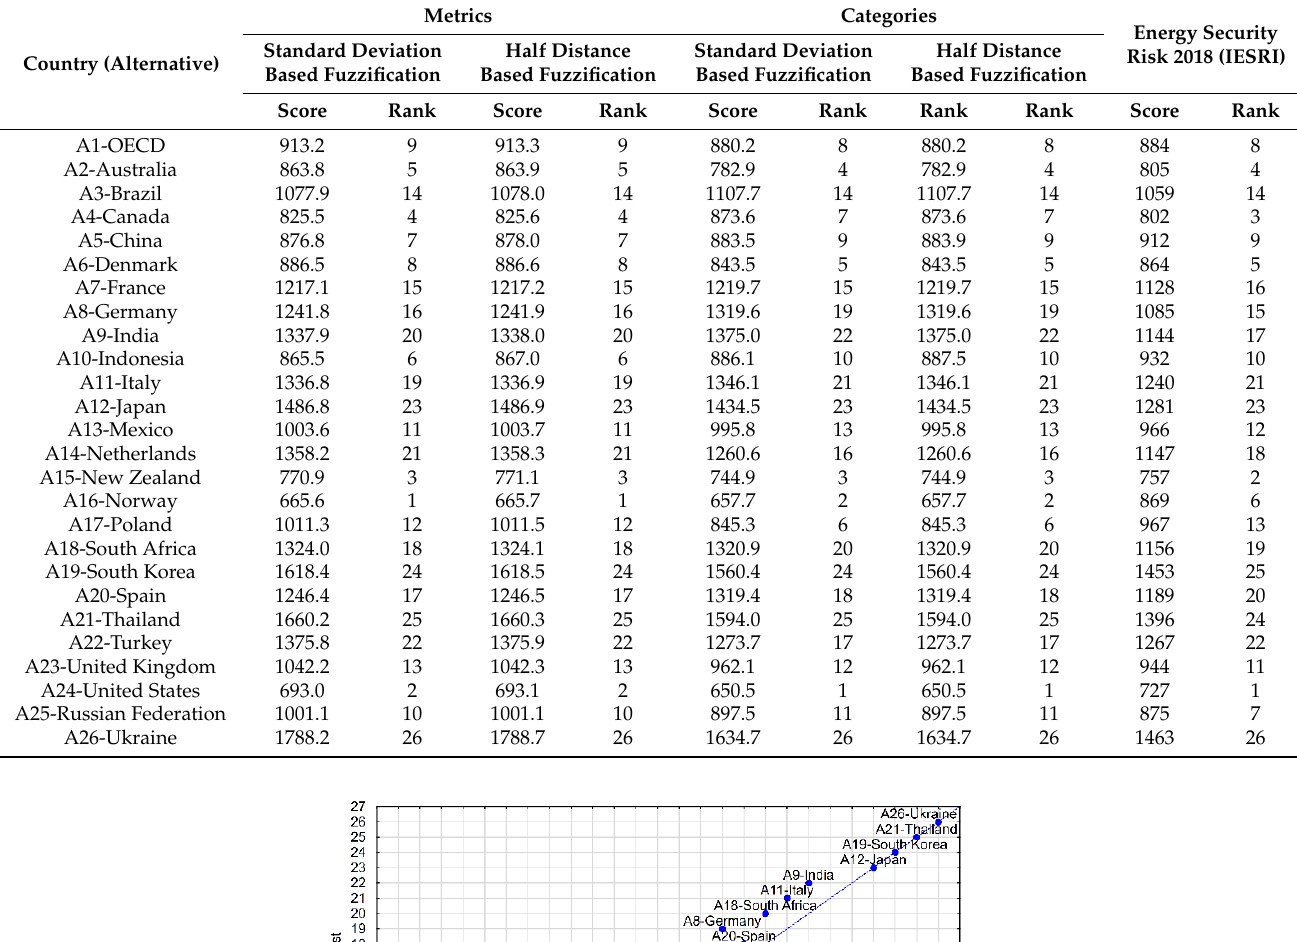
Country (Alternative)